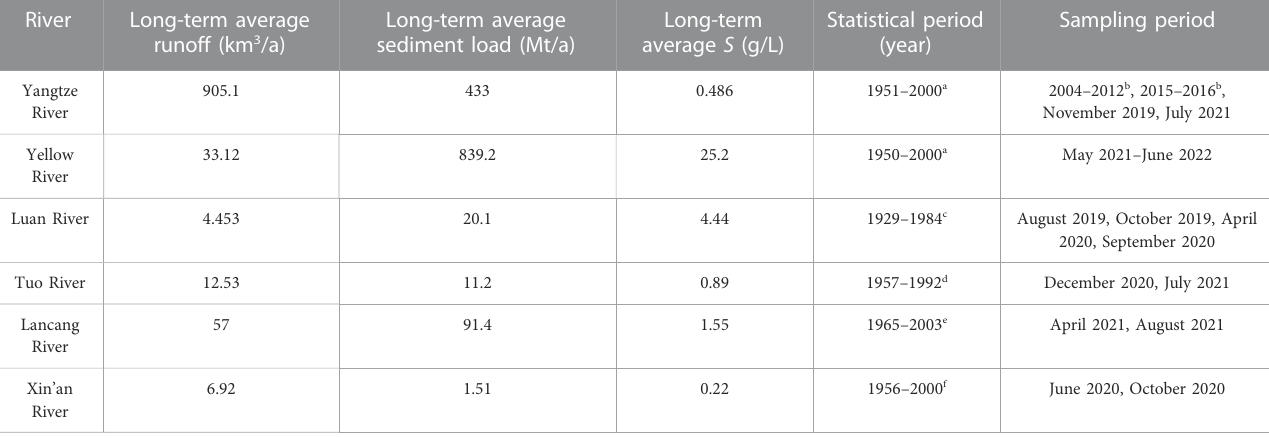
TABLE 1 Basic characteristics of the six different rivers in China selected for this study and their sampling